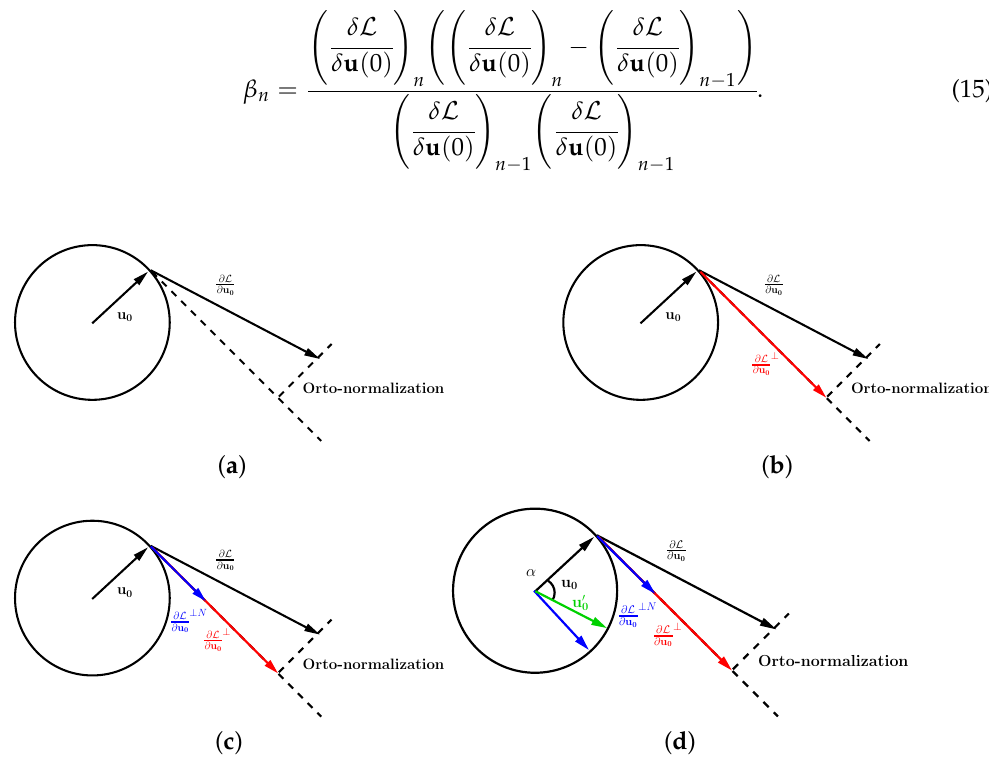
Figure 4. Simplified sketch representing the procedure used to update the solution u ( 0 ) n . ( a ) Com- δ L pute the gradient direction . ( b ) Compute the perpendicular component of the gradient δ u ( 0 ) with respect to u ( 0 ) . ( c ) Normalize the perpendicular gradient with initial energy E 0 . ( d ) Update u ( 0 ) . Notice that, as the update (13) has almost the same form as in (9), the orthogonal conjugate gradient can be easily normalized to the energy E 0 using an equation equivalent to (12), obtained by injecting the expression for the updated initial perturbation (13) in the constraint (10). Thus, for the present algorithm, the step 6 of the direct-adjoint looping is split in the following